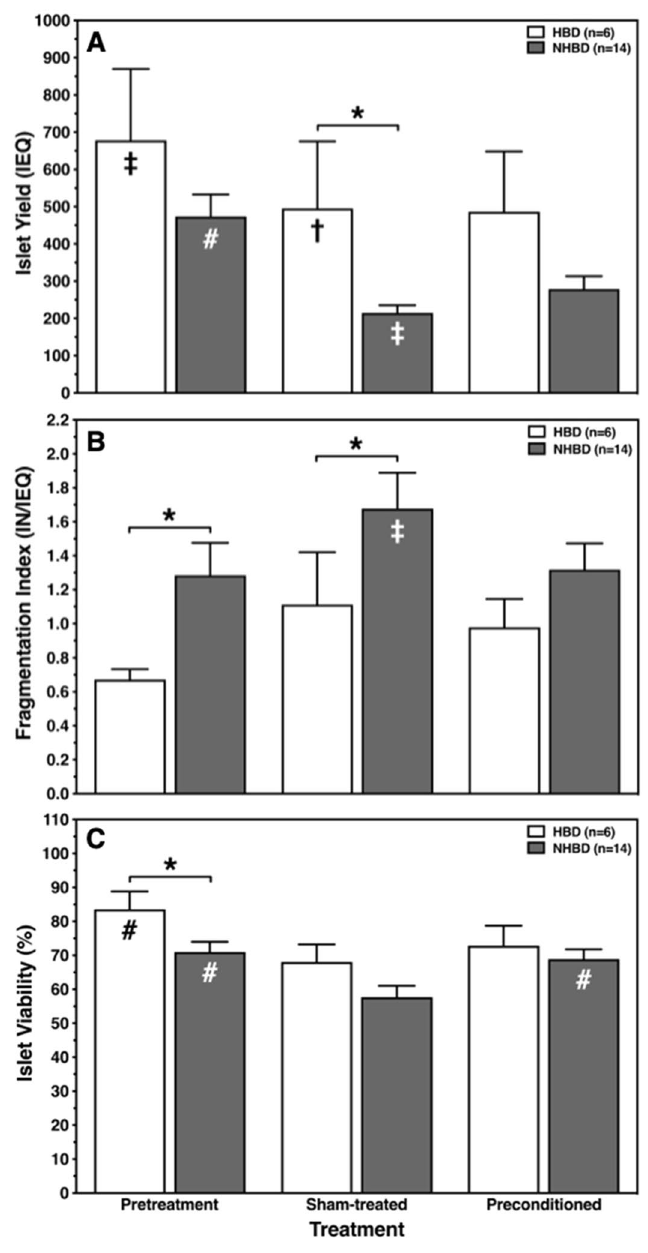
(NHBD, n = 14, grey bars). Islet yield ( A ), fragmentation index ( B ) and viability ( C ) were assessed immediately post isolation (pretreatment) and after sham-treatment or preconditioning followed by 24 h-culture of preconditioned or sham-treated islets in hypoxic atmosphere, respectively. * p < 0.05 for HBD versus NHBD. Symbols inside bars indicate † p < 0.05 versus corresponding pretreatment; ‡ p < 0.01 versus corresponding preconditioning; # p < 0.001 versus corresponding